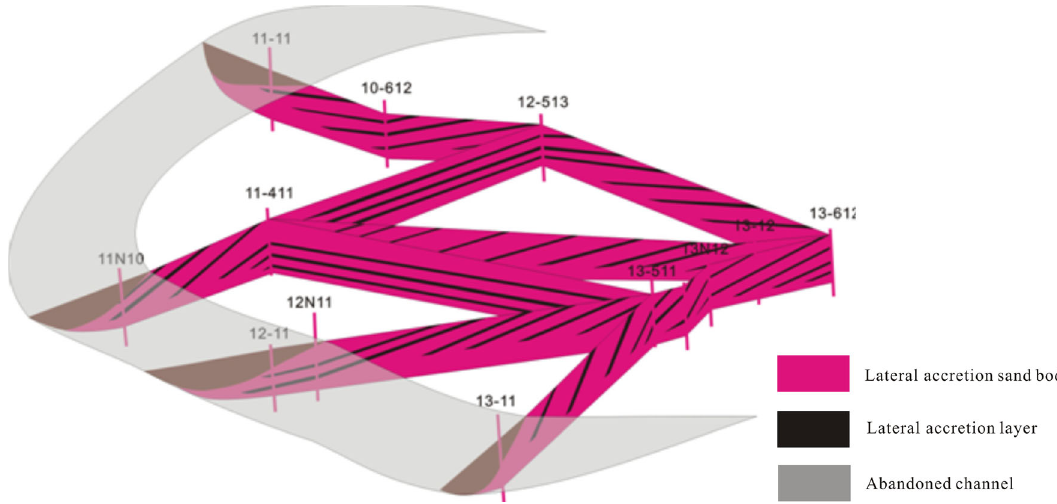
Fig. 7 Anatomy of inner point bar using well data and quantity model of point bar